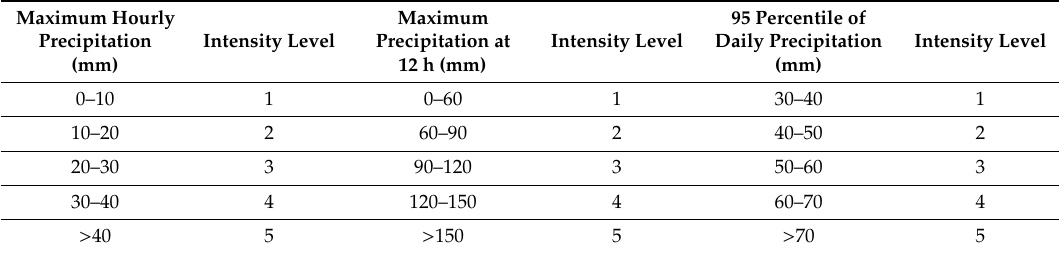
Table 5. Ranking of precipitation intensity levels for di ff erent time durations.